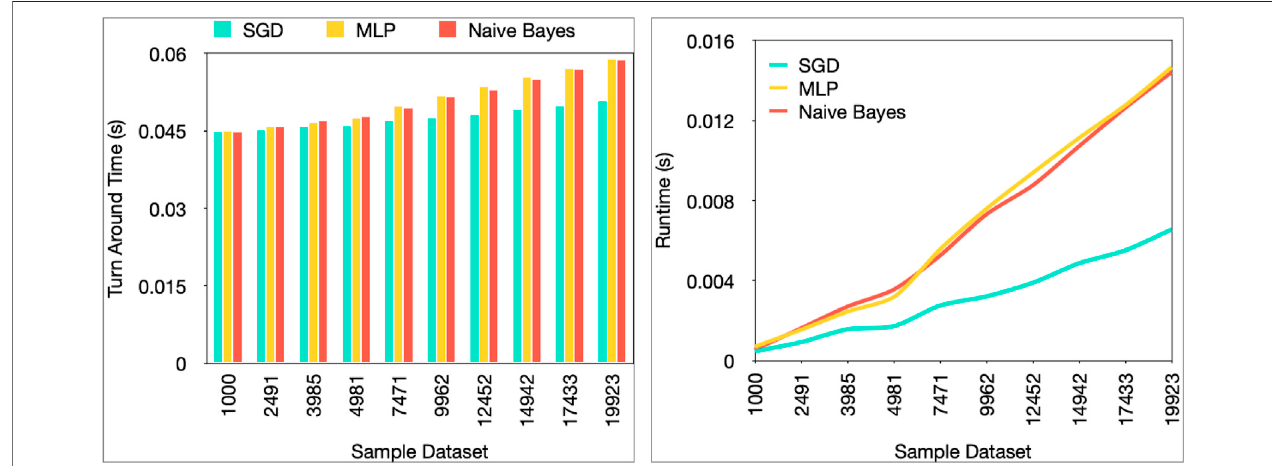
FIGURE 6 | Comparing different machine learning models.